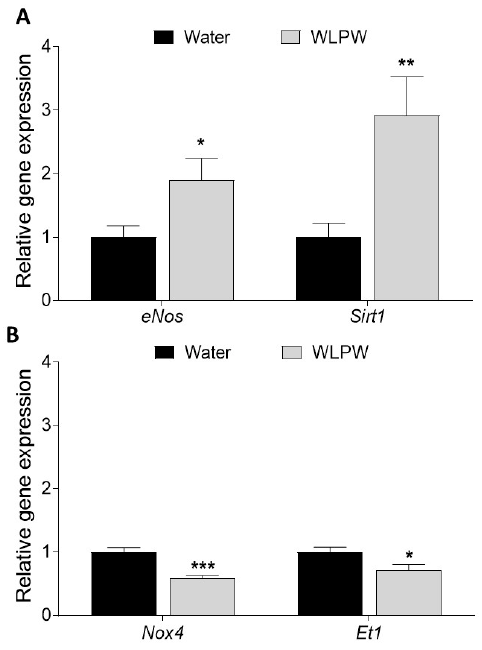
Figure 5. Aortic gene expression of eNos and Sirt1 ( A ) and Nox4 and Et1 ( B ) in spontaneously hypertensive rats 6 h after administration with water or wine lees powder (WLPW). Statistical differences between treatments were carried out by Student’s t -test when (*) p < 0.05, (**) p < 0.01 or (***) p > 0.001.